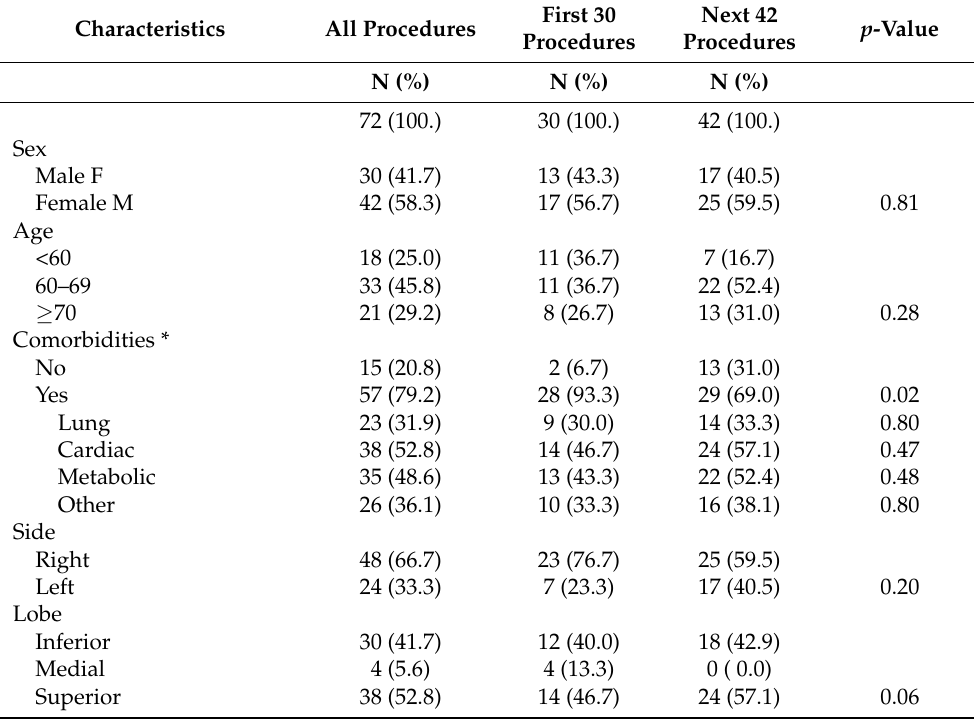
Table 1. Demographic, clinical and pathological outcomes of the